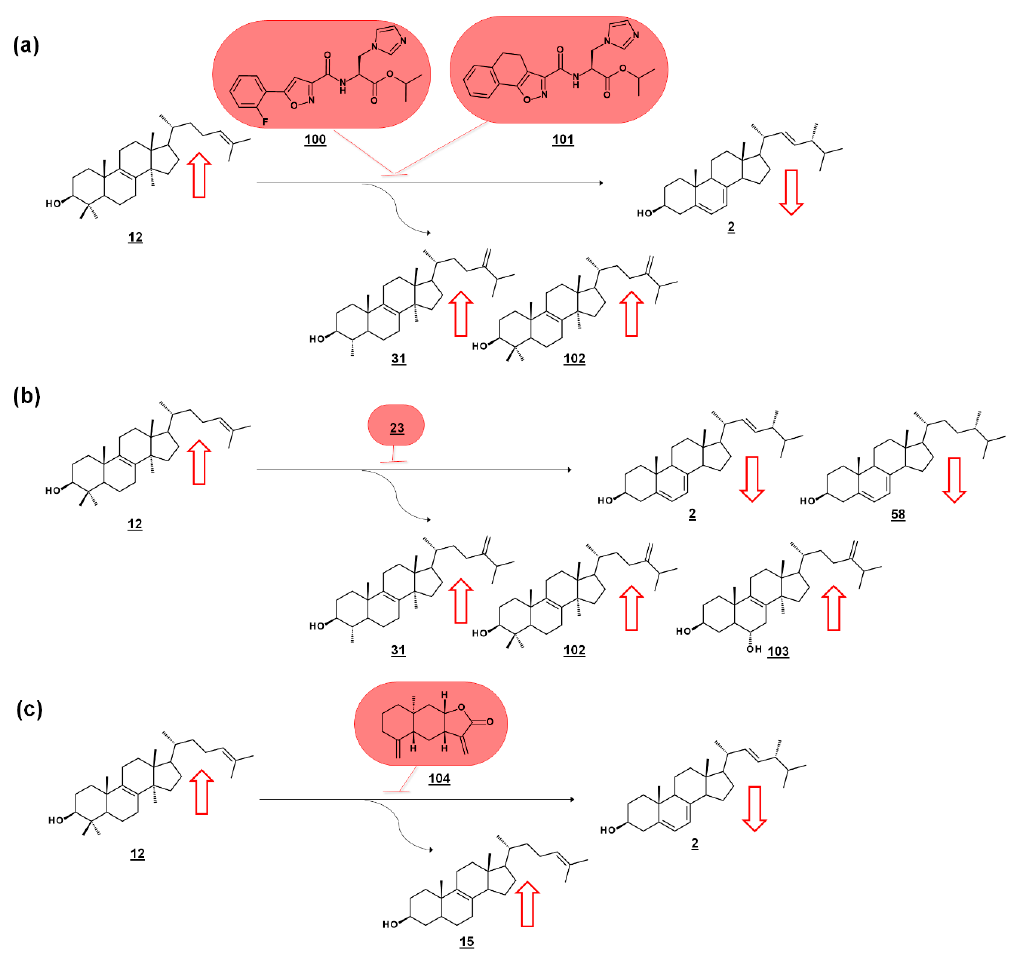
Figure 11. Sterolomic identification of ergosterol biosynthesis inhibitors (EBIs) in fungi. Red arrows signify increase or decrease in sterols within the profile of inhibited cultures relative to non-inhibited cultures. ( a ) Oxazole amidoester-treated cultures of C. albicans decrease in ergosterol and increase in lanosterol and by-products obtusifoliol and eburicol, indicating disruption of 14-SDM activity [77,78]. ( b ) Posaconazole-treated cultures of Rhizopus arrhizus decrease in ergosterol and ergosta-5,7-dienol and increase in lanosterol, obtusifoliol, and eburicol, and produce toxic 14-methylergosta-8,24(28)-dien-3 β ,6 α -diol [79]. ( c ) ent -Isoalantolactone-treated cultures of C. albicans decrease in ergosterol and increase in lanosterol and zymosterol, indicating disruption of 24-SMT activity